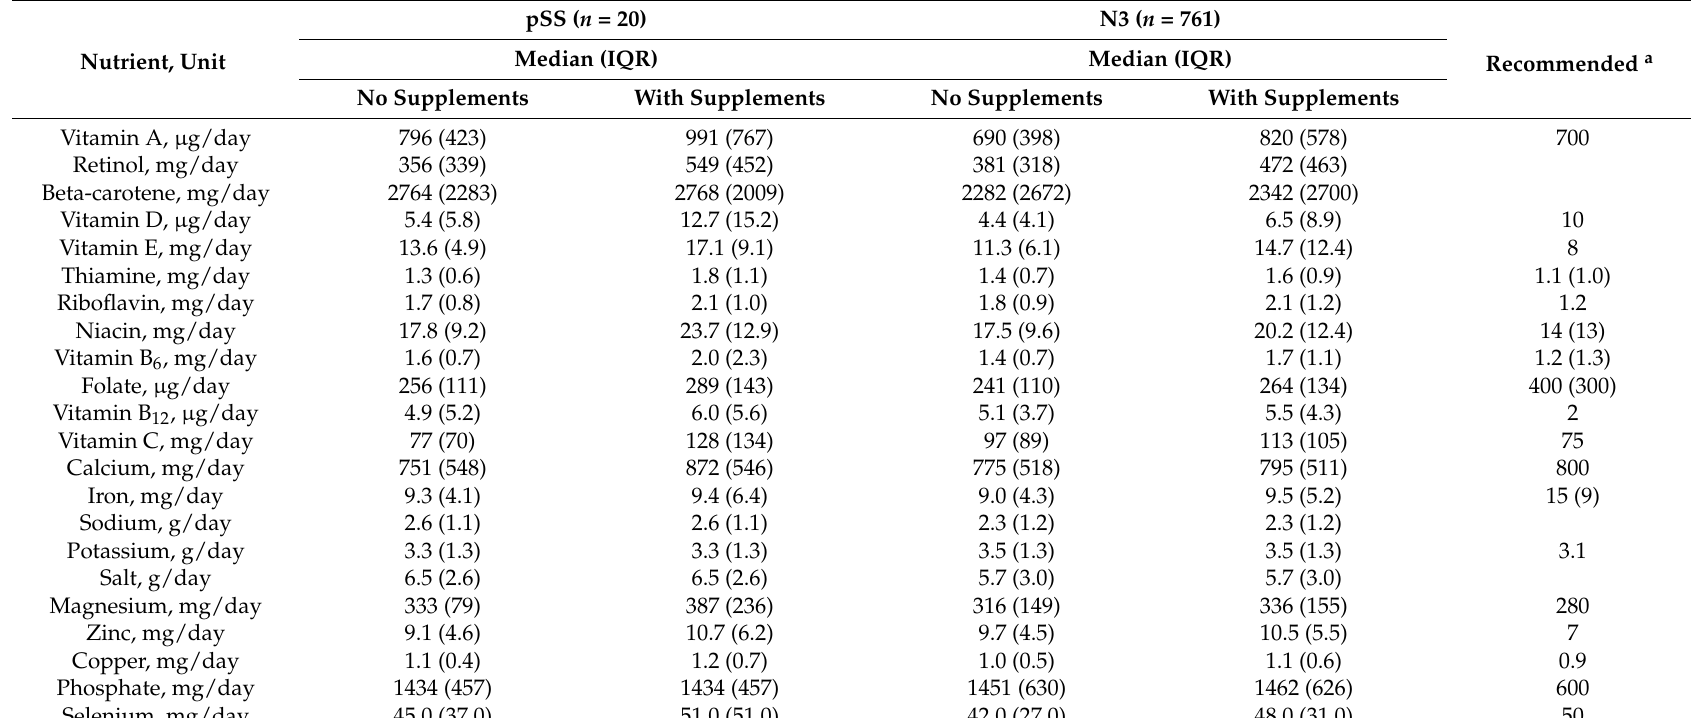
Table 4. Intake of micronutrients among the pSS-patients and the N3-reference